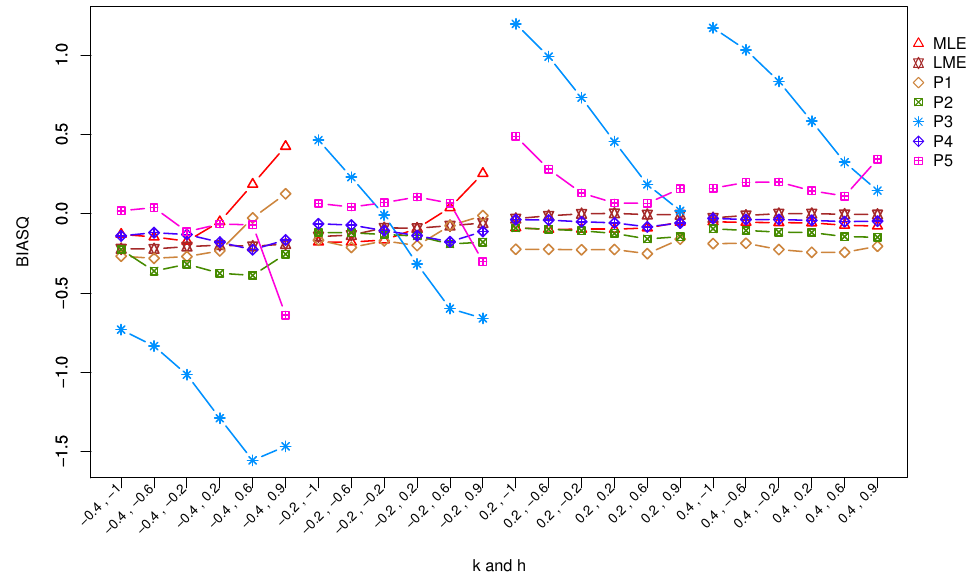
Figure 5. Same as Figure 3, but for the bias of the estimates for the 95th percentile (BIASQ).